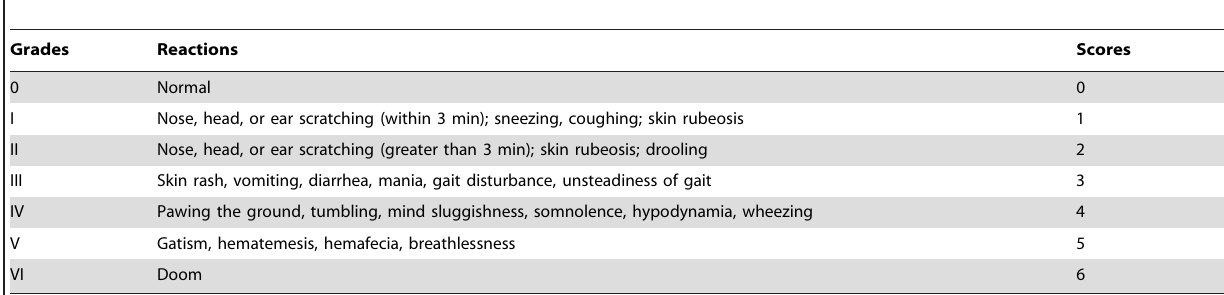
Table 1. An assessment norm for the anaphylactoid reactions and anaphylaxis in dogs.